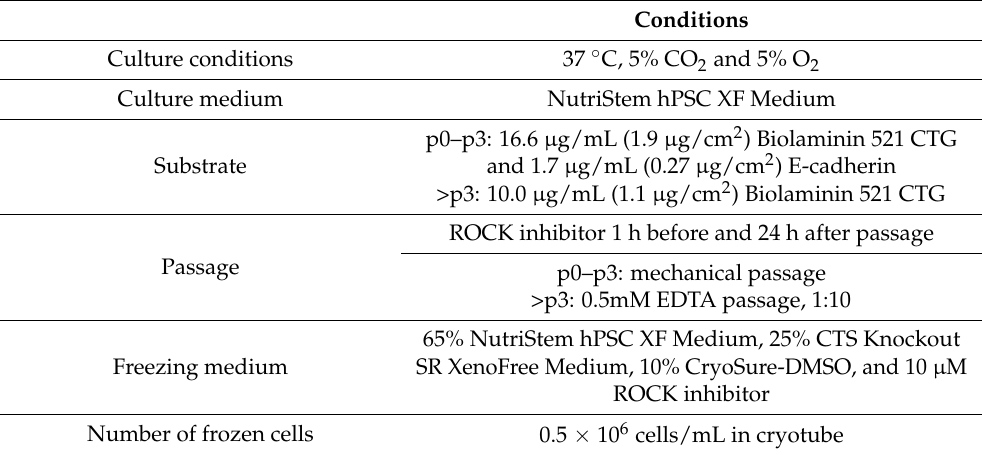
Table 3. Overview of the culture conditions, medium, passage, and freezing for the hESC lines MUCG01, MUCG02, and MUCG03.